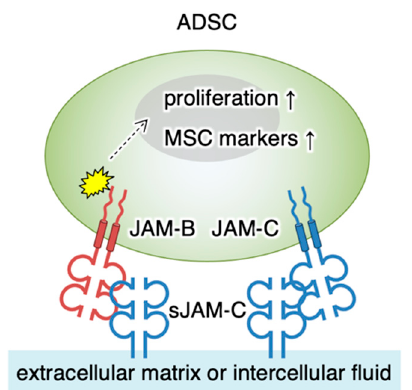
Figure 8. Schematic model for the regulation of ADSC functions by soluble JAM-C. The soluble JAM-C (sJAM-C) deposited on the extracellular matrix interacts with JAM-B and partly with JAM-C on ADSC. sJAM-C/JAM-B signaling reaches the nucleus (dashed arrow) and stimulates cellular proliferation and expression of MSC markers (arrows). MSC, mesenchymal stromal/stem cell.